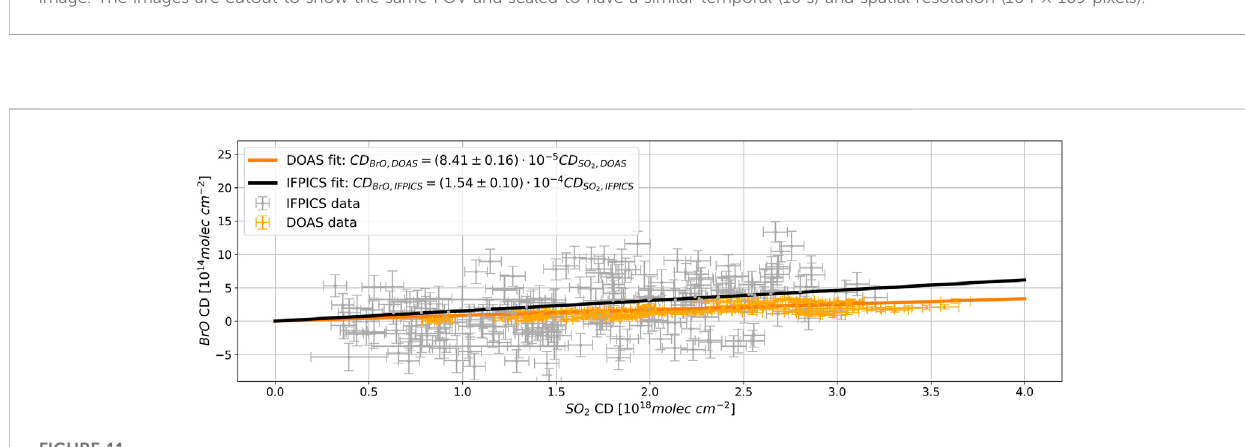
Frontiers in Earth